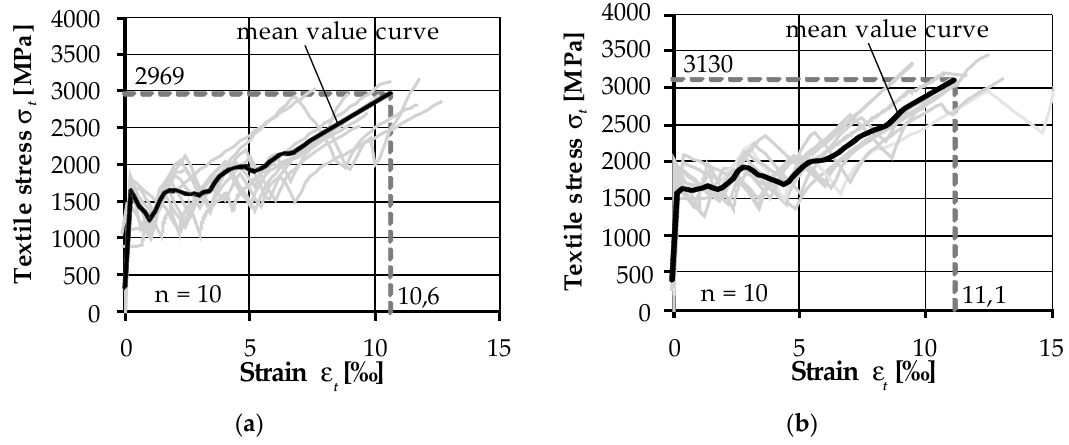
Figure 4. Results of the first ( a ) and second ( b ) short-term test series.